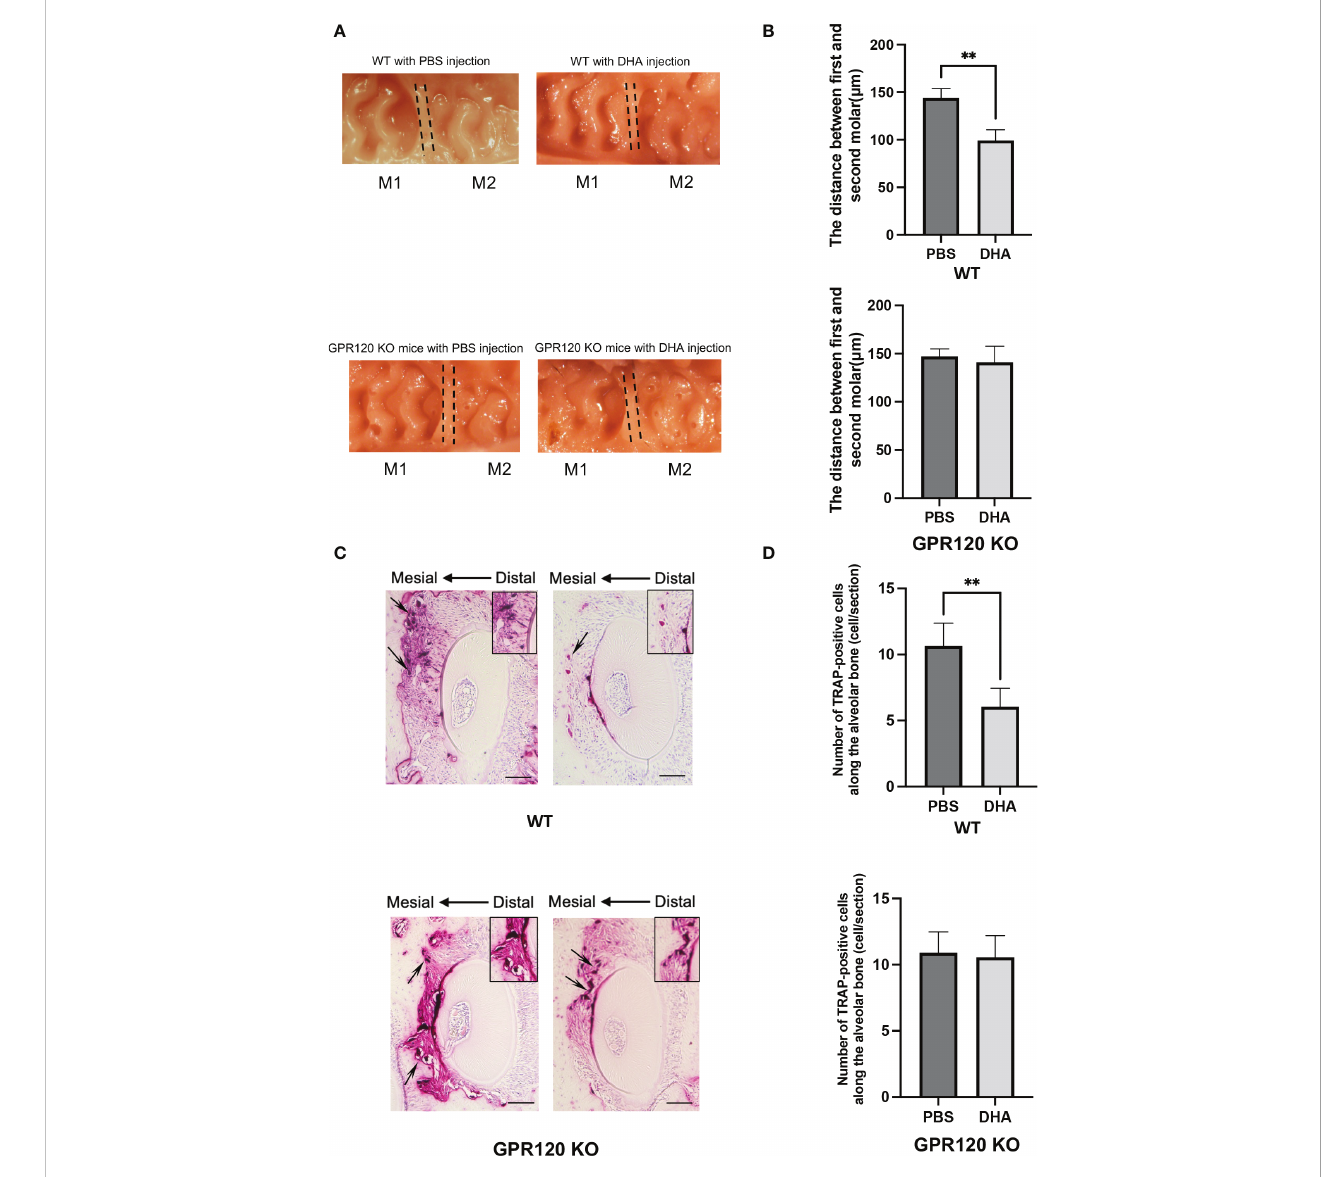
FIGURE 6 Tooth movement in WT and GPR120-KO mice treated with or without DHA after 12 days of OTM. (A) Images of a 12-day duration of orthodontic tooth movement in WT and GPR120-KO mice with PBS or DHA. (B) Measurement of the distance between the fi rst and the second molar in WT and GPR120- KO mice with PBS or DHA after 12-day force loading. (C) TRAP-stained histological sections of the distobuccal root of the maxillary left fi rst molar of WT and GPR120-KO mice after a 12-day duration of orthodontic tooth movement. The arrows show the osteoclasts formation and bone resorption area along the root. (D) The number of TRAP-positive cells along the alveolar bone surface around the distobuccal root of the left maxillary fi rst molar after 12-day orthodontic tooth movement of WT and GPR120-KO mice treated with PBS or DHA. The results are given as means ± SD. Scheffe ́ ’ s test was used to determine the statistical signi fi cance of differences (n = 4; ** p < 0.01). Scale bars = 50 m